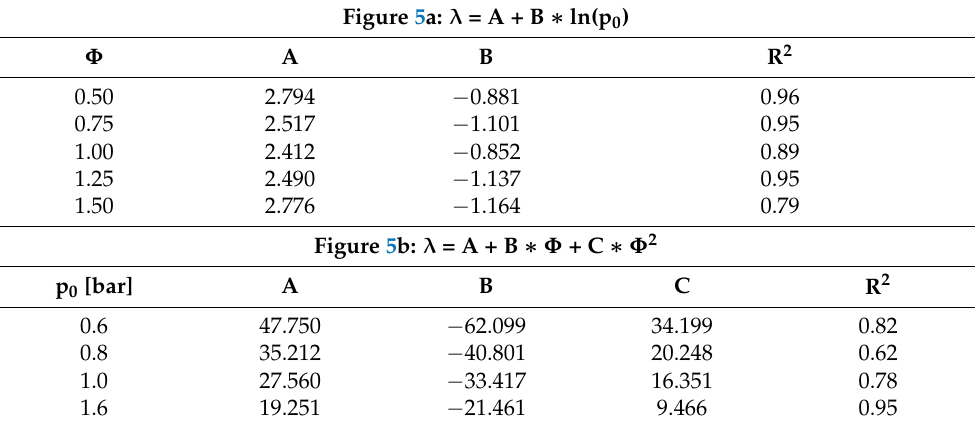
Table 3. Equations and R 2 of the fitted curves from Figure 5. Figure 5a: λ = A + B ∗ ln(p 0 )